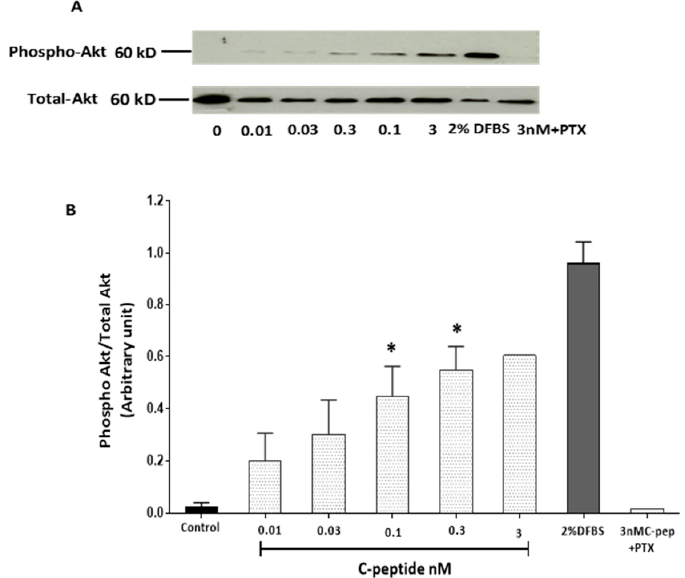
Figure 1. Rat C-peptide activates ERK1/2 in rat skeletal muscle cell line L6. L6 myoblasts cells were stimulated with rat C-peptide for 5 min in Dulbecco’s Modified Eagle’s Medium (DMEM). ( A ) Phosphorylation of ERK1/2 was determined by the Western blot using specific anti-phospho ERK1/2 antibody. 2% dialysed foetal bovine serum (DFBS) was used as a positive control. As a loading control, membranes were reprobed with an antibody against ERK2. Quantification by densitometry of data from three such experiments is presented in histograms; ( B ) as mean ± SEM . * p < 0.05 versus the unstimulated control.